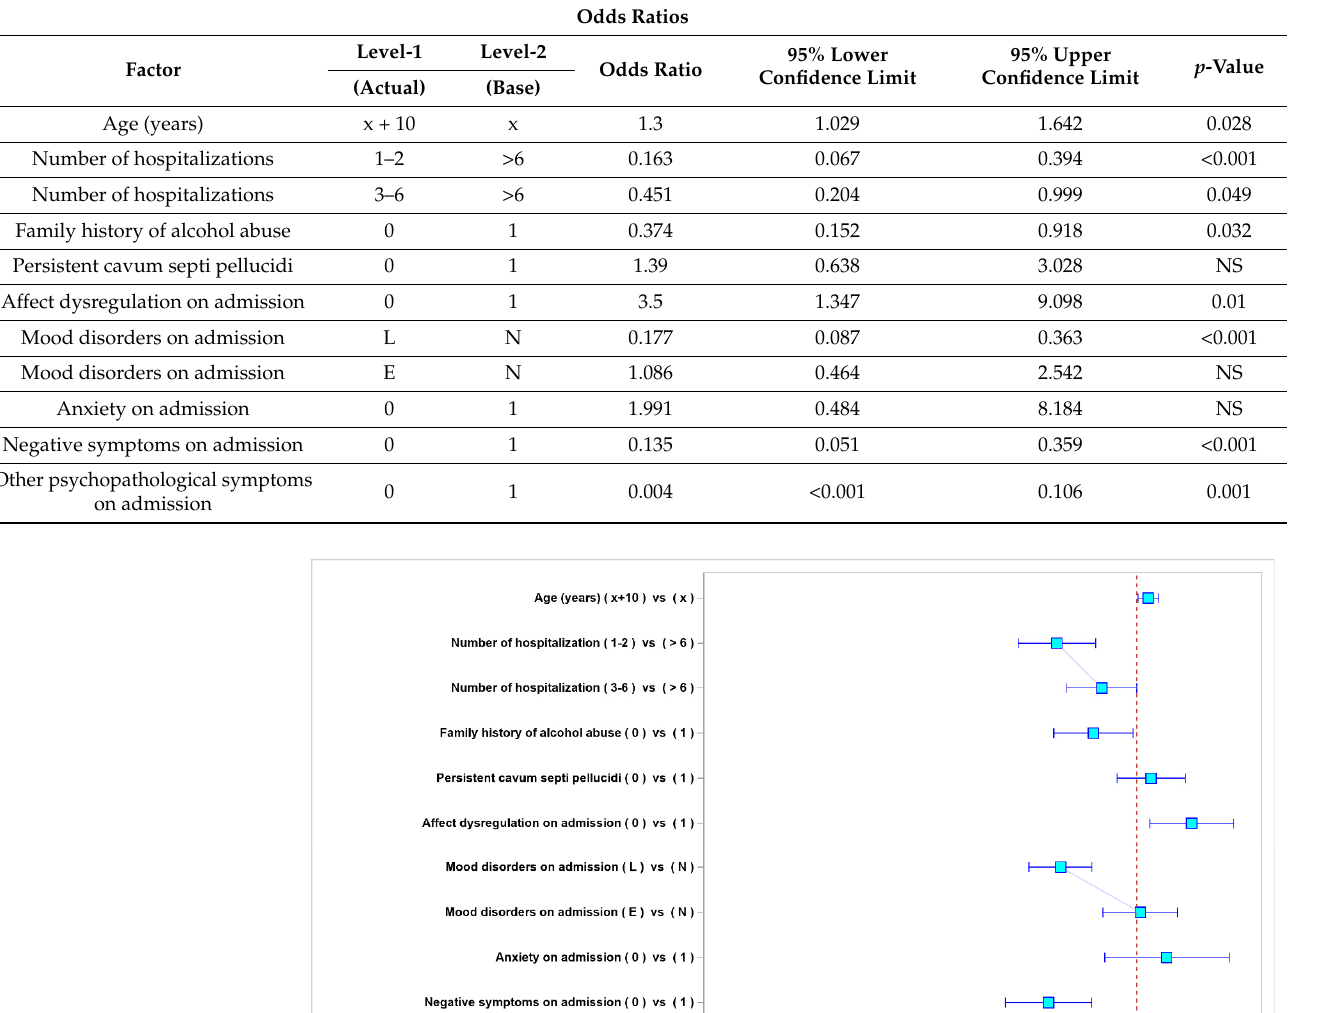
Table 4. Multivariate model—odds ratio values for the parameters affecting the presence of other symptoms at hospital discharge.